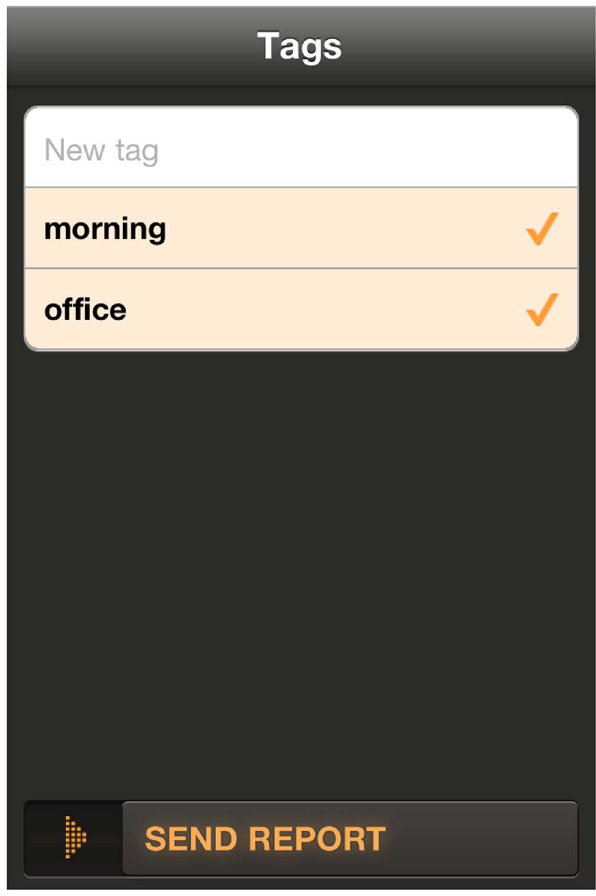
Figure 3. Tag screen for WideNoise Plus mobile application.